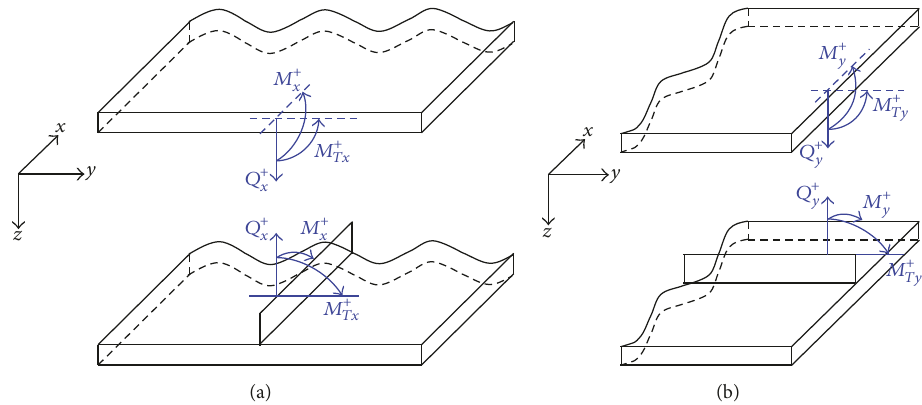
Figure 4: Convention for tensional forces, bending moments, and torsional moments between top facesheet and (a) 𝑥 -wise and (b) 𝑦 -wise stiffeners.